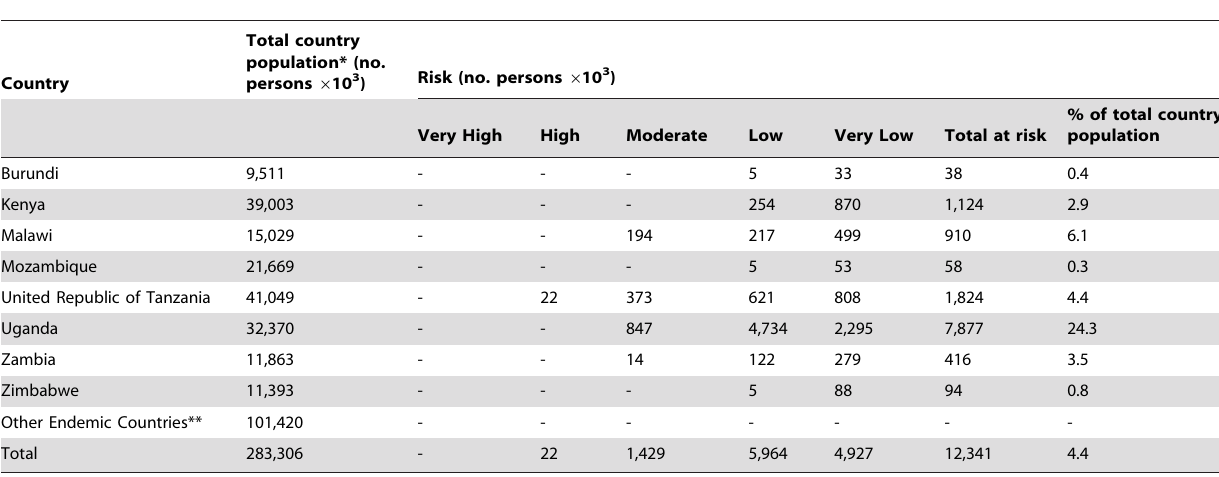
Table 5. Population at risk of T. b. rhodesiense infection in eastern and southern Africa (no. persons 6 10 3 ).